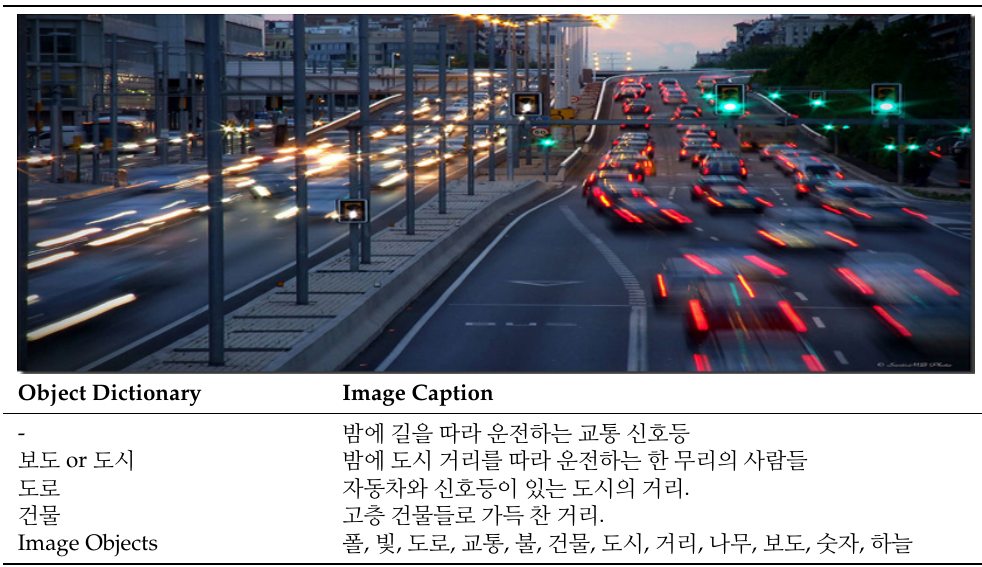
Table 5. Korean image captioning examples of various image captions generated according to object dictionary in one picture. We show that image captions are generated differently for each dictionary change on the